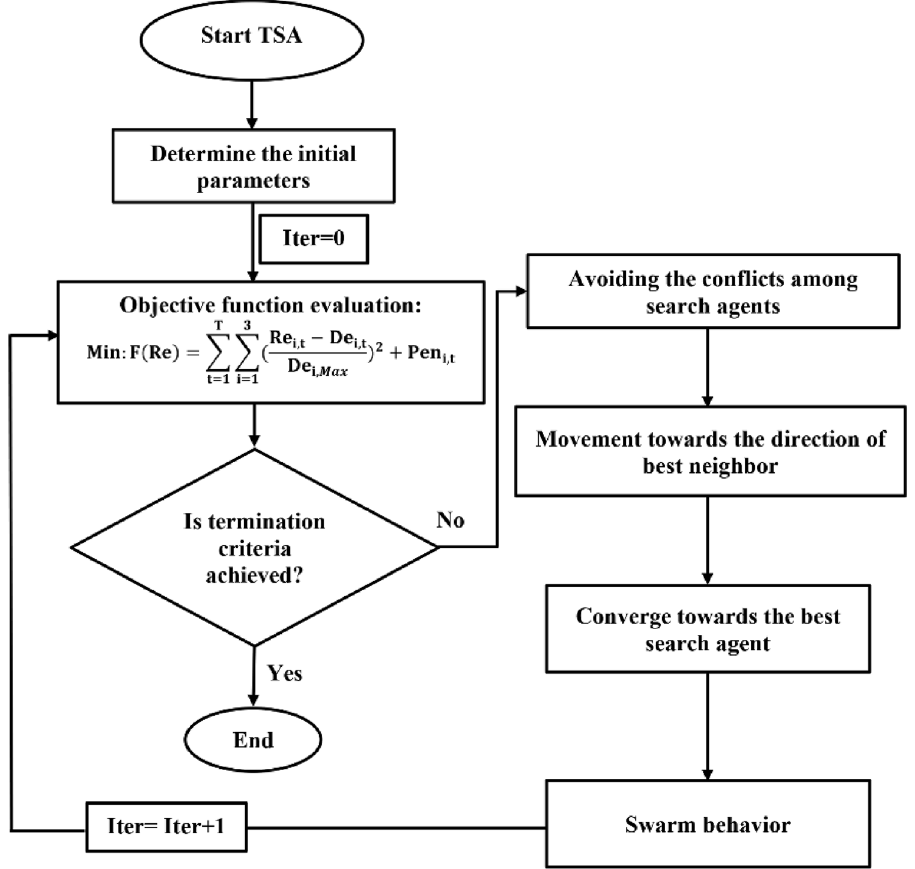
Figure 1. Flowchart of TSA algorithm in the optimal operation of Halilrood multi-reservoirs system.